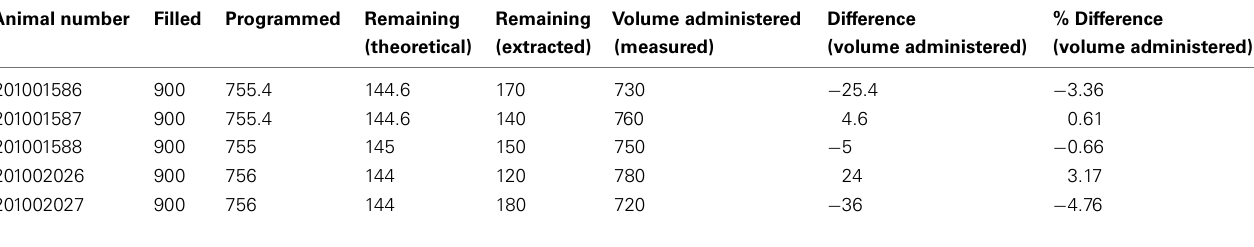
Table 6 | Individual data for infusion verification and validation for the 30 μ l/hValsartan ® infusion. Animal number Filled Programmed